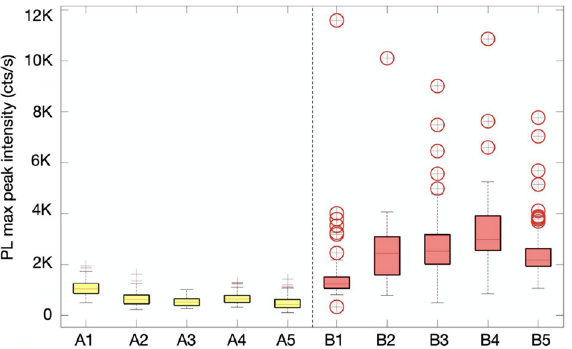
Figure 5. Boxplot showing the distribution of the PL maximum peak intensity for two groups at five marked different areas. PL measurements were performed on control sample A and plasmonic sample B. Each marked point has an area of 25 × 35 μm. Red circles refer to abnormal PL intensity values, which indicate the presence of the Au